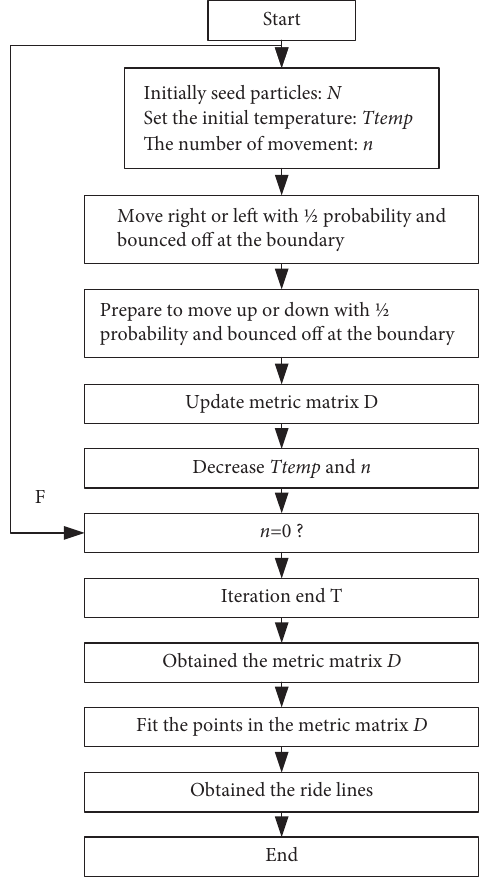
Figure 1: Flowchart of the Crazy Climber